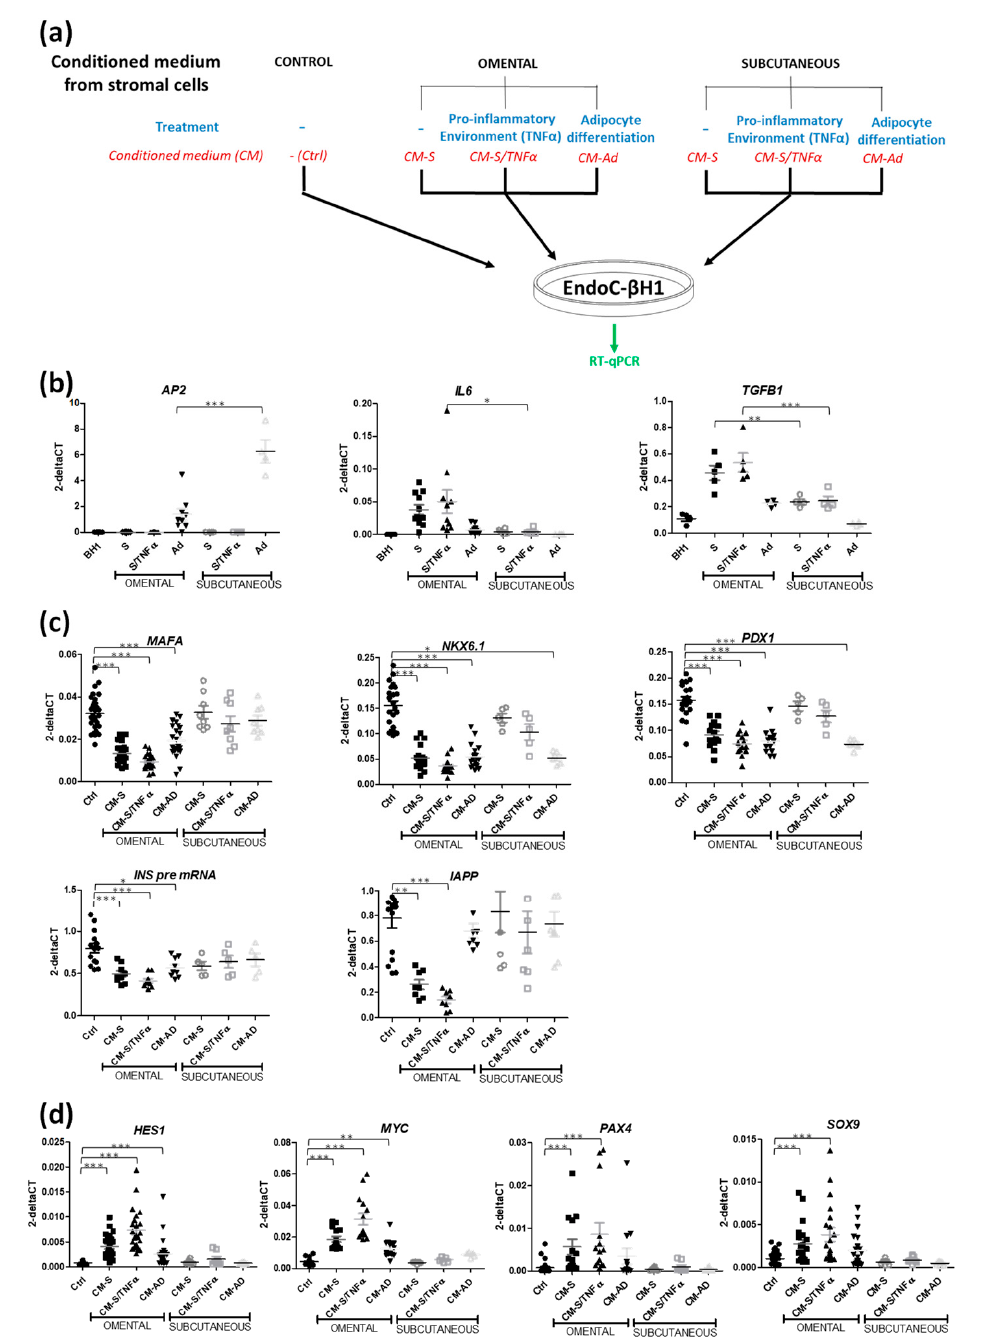
Figure 4. CM from subcutaneous stromal cells does not recapitulate the effects of CM from omental stromal cells. ( a ) Experimental scheme. ( b ) qPCR analyses of AP2 , IL6 and TGFB1 mRNA in omental and subcutaneous cells (either control, inflamed or differentiated into adipocytes) (n = 4–10). ( c , d ) EndoC- β H1 cells were exposed to CMs from omental or subcutaneous stromal cells for 48 h. Beta cell-specific genes ( MAFA, NKX6-1, PDX1, INS pre-mRNA, IAPP ) ( c ) and dedifferentiation markers ( HES1, c-MYC, PAX4, SOX9) ( d ) were analyzed by RT-qPCR (n = 5–23). Data are represented as mean ± SD. * p < 0.05, ** p < 0.01, *** p < 0.001.